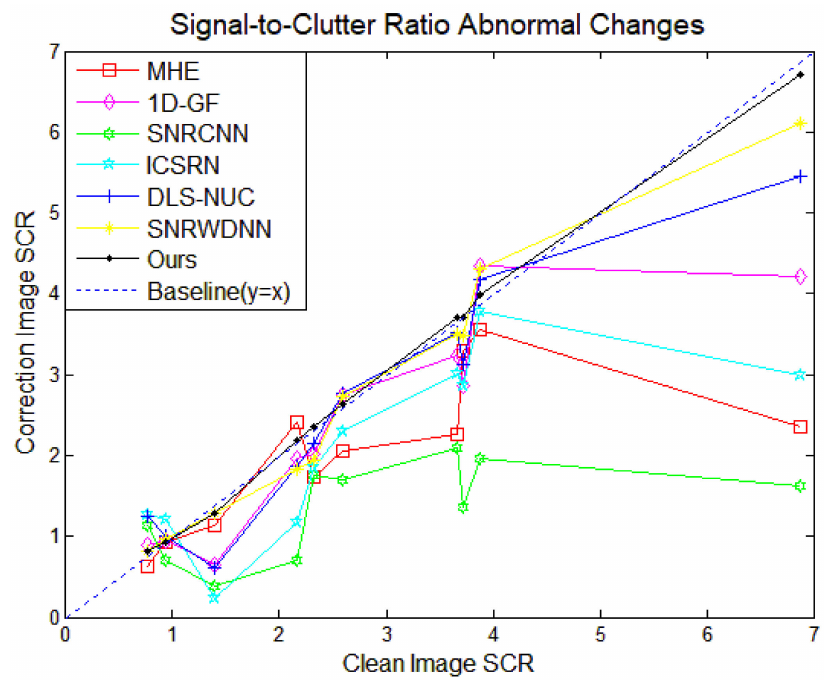
Figure 17. The line graph of each method performance on the SCR. The abscissa is the clean image SCR, and the ordinate is the corrected image SCR. The better the fitting with the baseline, the lower the possibility of removing dim small targets as noise